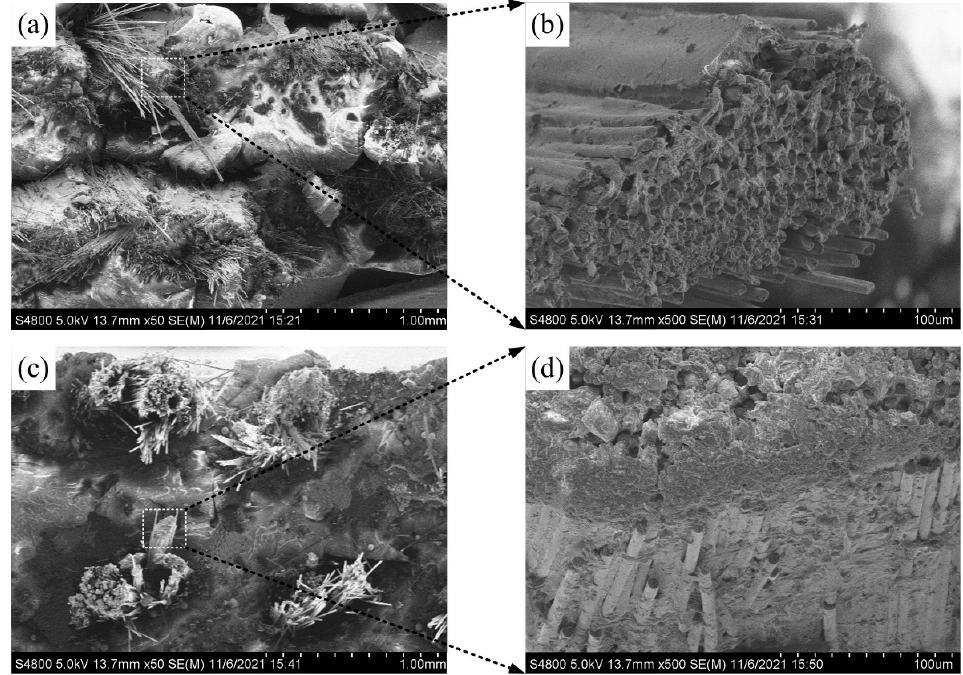
Figure 10. ( a , b ) The micromorphology of tensile test specimen at different magnifications—210 °C; ( c , d ) the micromorphology of tensile test specimen at different magnifications—240 °C.